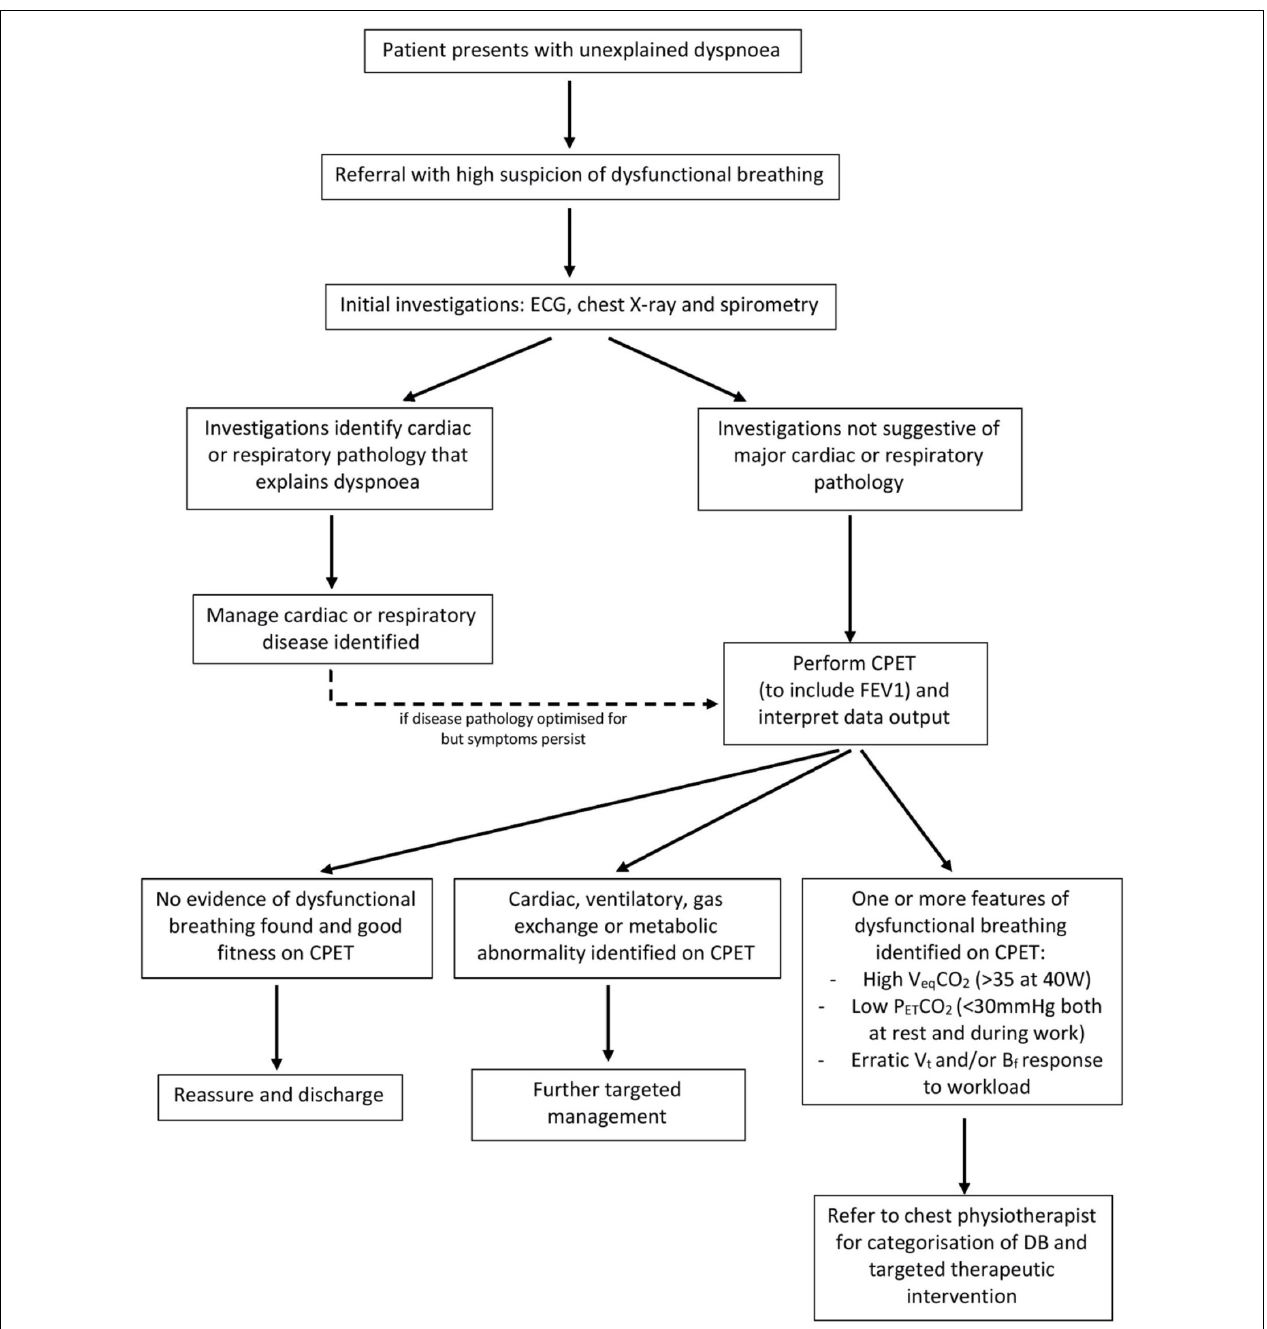
FIGURE 4 | Flowchart to illustrate a proposed clinical pathway for DB identification and therapy, based on current practice at Cambridge University Hospitals NHS trust. Suggested cut-off values are based on studies cited in this paper (Kinnula and Sovijarvi, 1993; Brat et al., 2019). FEV1, forced expiratory volume in 1 s; VeqCO2, ventilatory equivalent for CO2; P ET CO2, end-tidal CO2; V t , tidal volume; B f , breathing